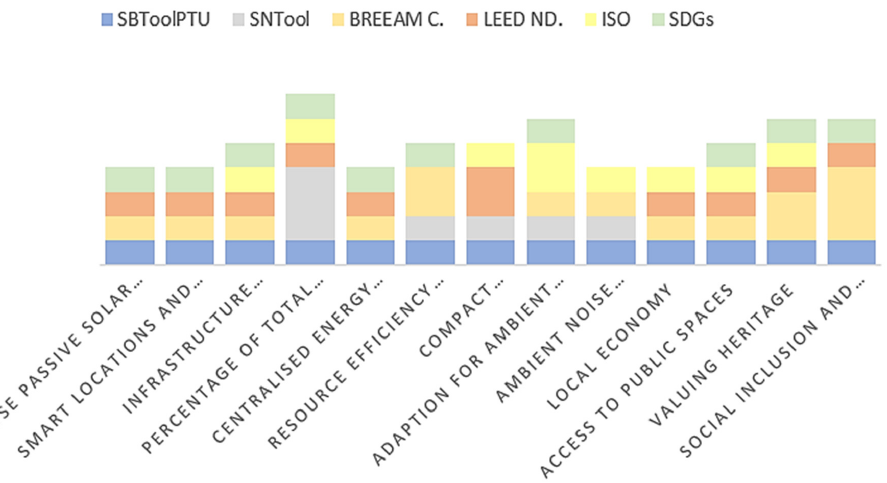
Figure 15. Frequency distribution of each indicator, which are included in the three sustainability tools: SBTool PT _Urban (2018), SNTool Min (2020), BREEAM-C (2012), LEED-ND (2018), and supported by ISO 37120, and/or SDGs.